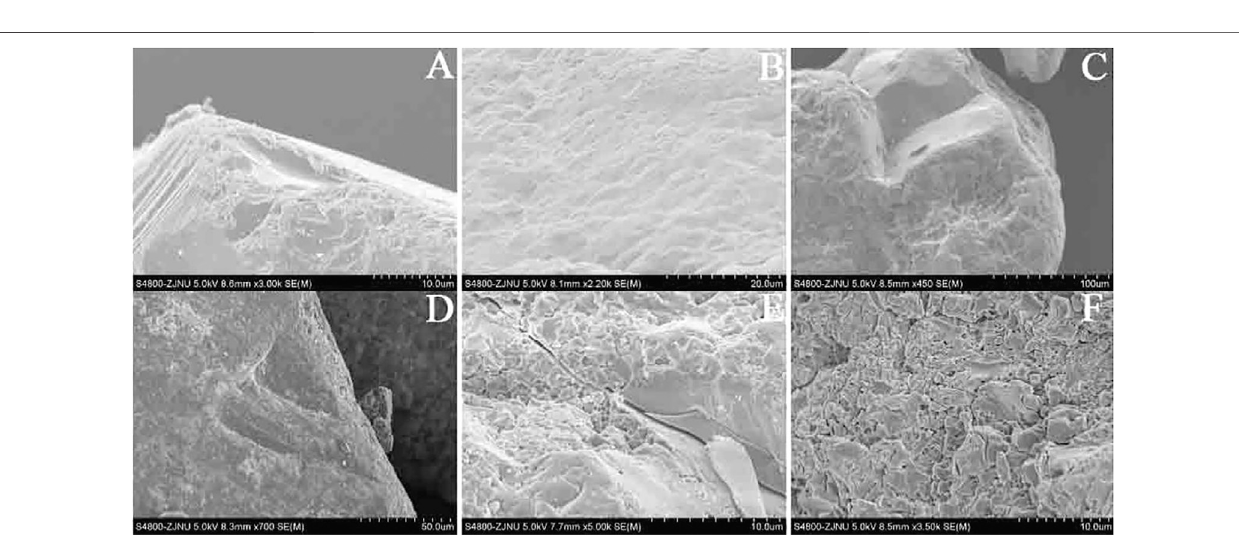
Frontiers in Earth Science |